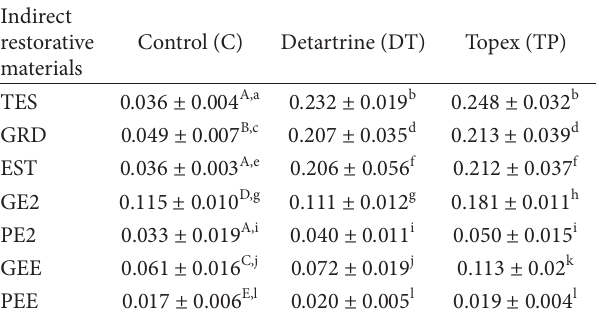
Different capital superscript letters in the control column indicated signif- icant differences between the control groups, while different superscript letters in the same row showed significant differences between control and PPPs applied groups for the same material ( 𝑃 < 0.05 ).